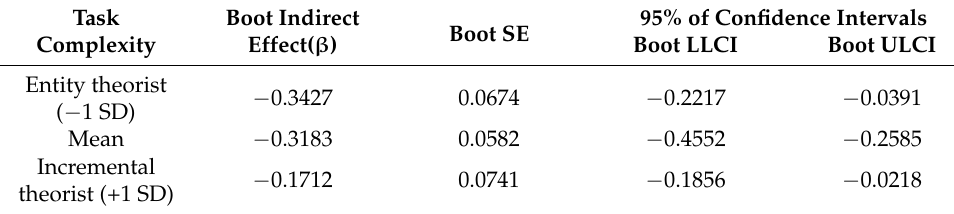
Table 9. Moderated mediation results for a conditional indirect